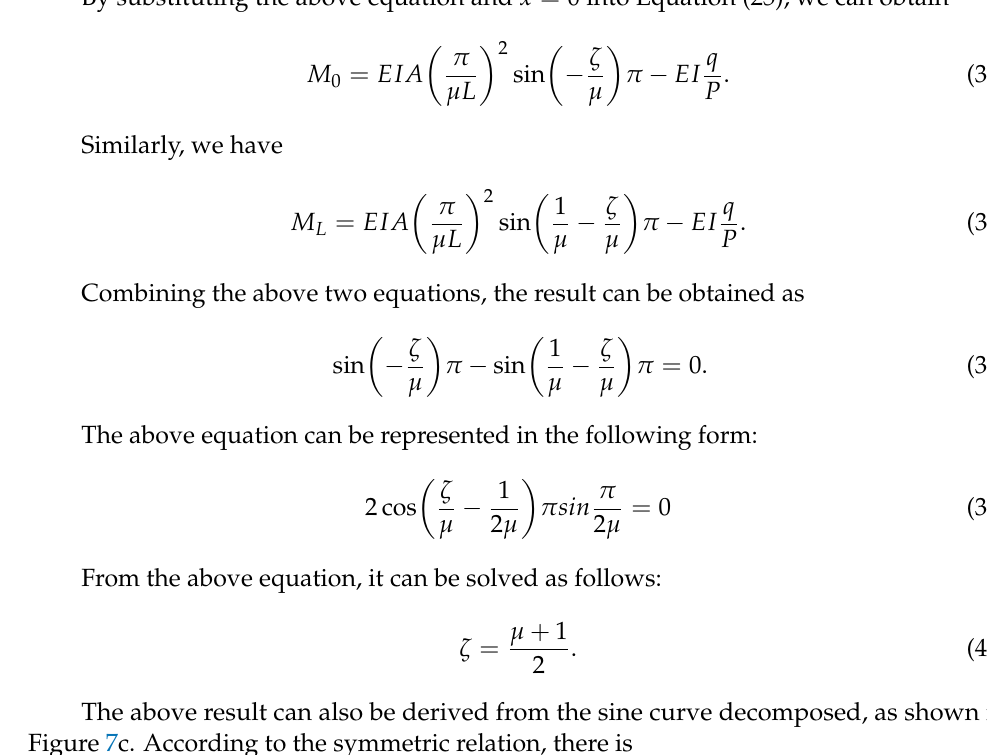
Figure 7. Schematic diagram of force superposition of a simply supported compression rod with equal bending moments at both ends under transverse uniform loads: ( a ) forces diagram of rod components; ( b ) deflection curve of the rod after deformation; ( c ) sine curve decomposed by the deflection curve; and ( d ) quadratic parabola decomposed by the deflection curve.